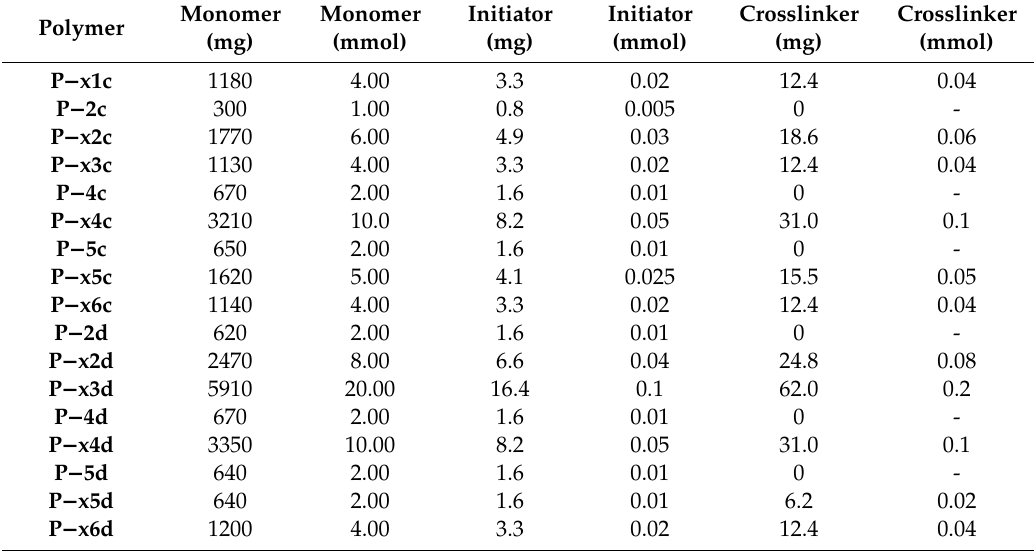
Table 1. Reaction conditions for the homo- and copolymerization of the sulfabetaine monomers